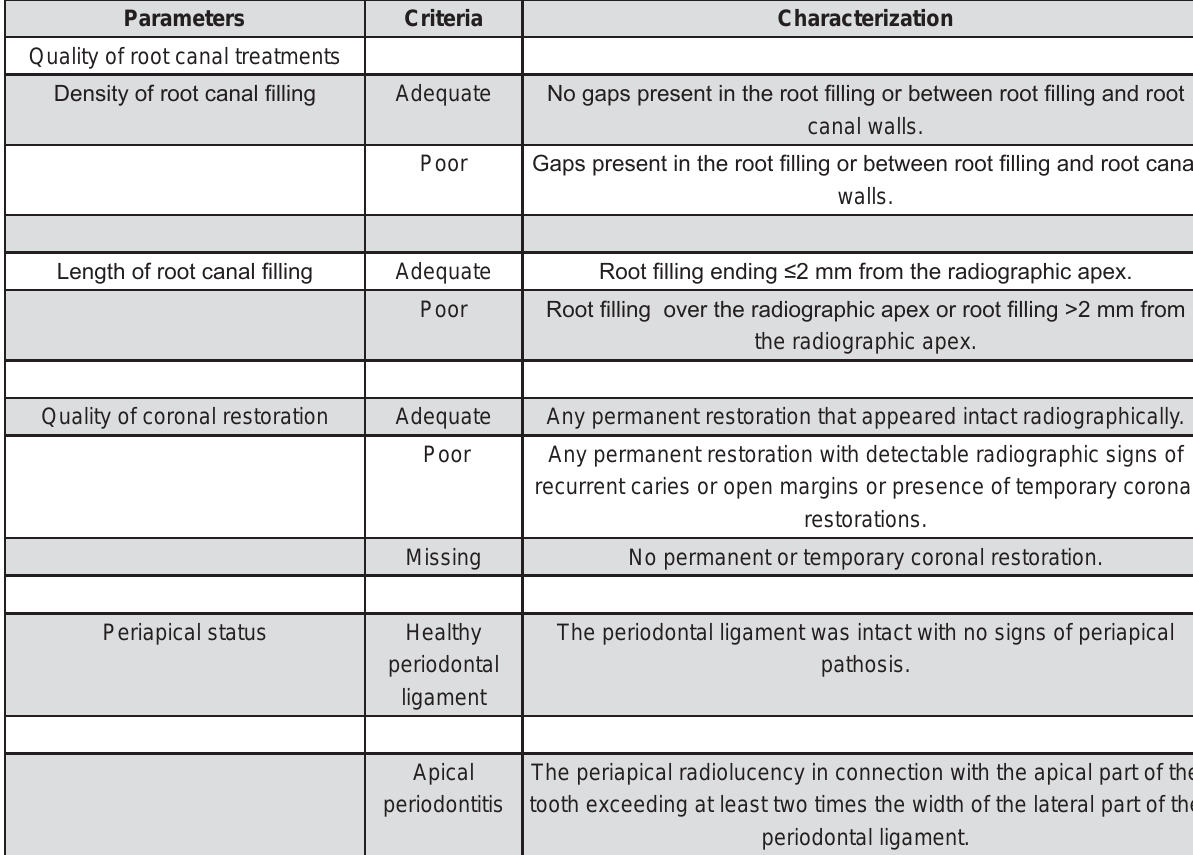
Figure 2- Parameters recorded on endodontically treated teeth with cone-beam computed tomography